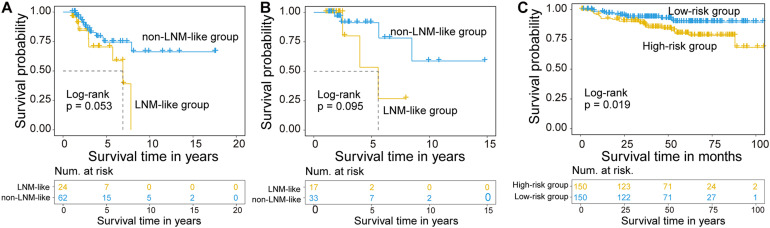
Association of the coding-non-coding RNA signature with prognosis. Kaplan-Meier survival curves of patients between different patient groups in the discovery cohort (A), testing cohort (B), and GSE44001 (C).